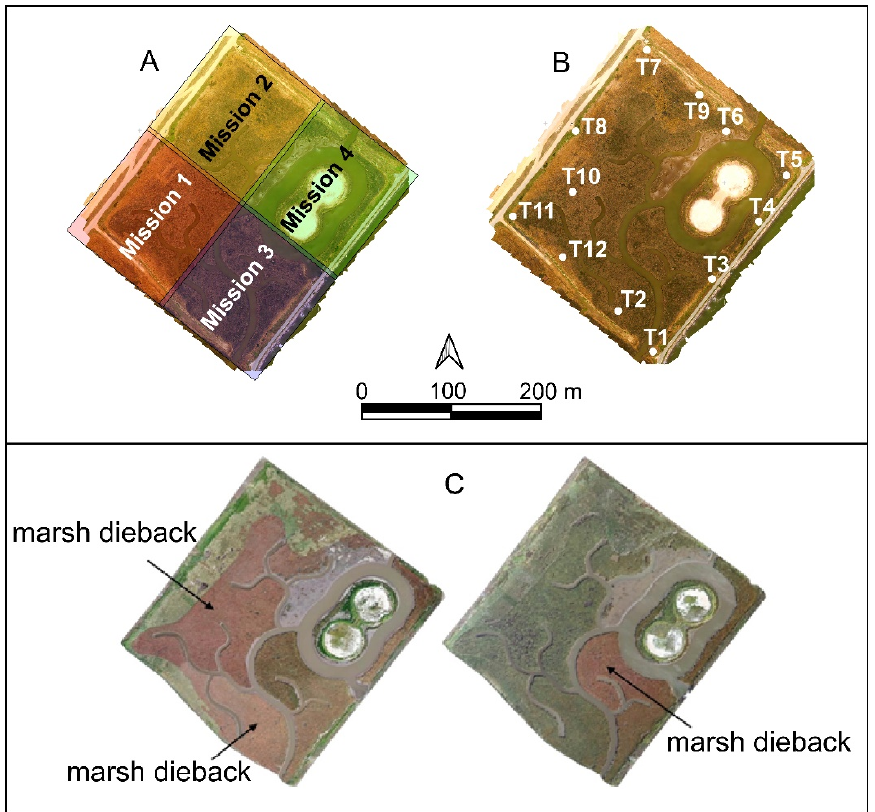
Figure 4. ( A ) Scheme of the planned flight missions (Pix4D Capture). ( B ) Position of GCPs for the UAV survey in November 2019. ( C ) Images of Cell 1B from September 2013 on the left and September 2014 on the right. Black arrows point to marsh areas affected by vegetation dieback, which are represented by brown senescent plants of S. alterniflora .